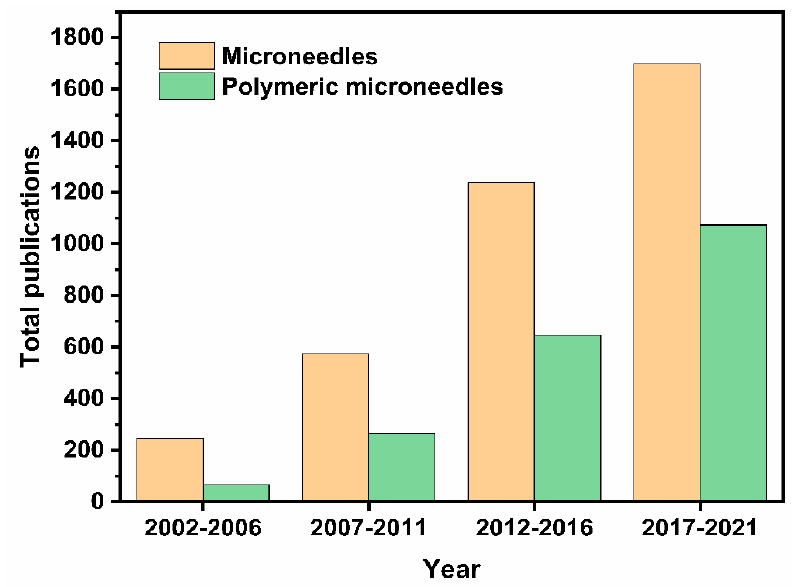
Figure 1. Bar charts displaying the total number of publications on MNs, and the number of MN publications related to polymeric MNs over the 5-year intervals. Information accessed on 26 June 2021 at www.scopus.com.